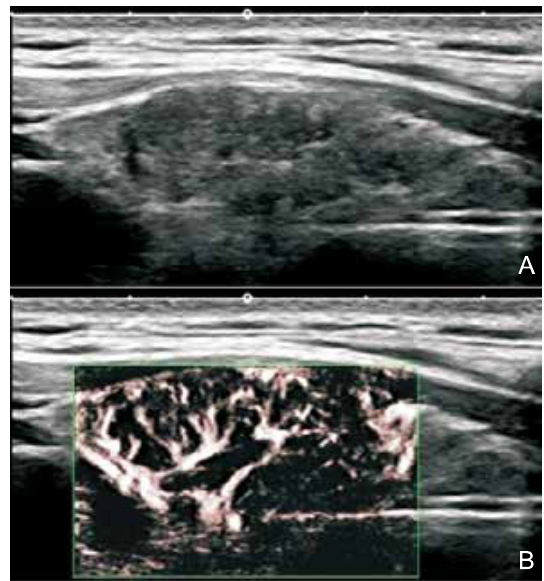
Figure 5 B-mode (A) and SMI (B) evaluation of a thyroid tumor is demonstrated. Notable tumor vascularity is appreciated. Image provided by Cannon Medical